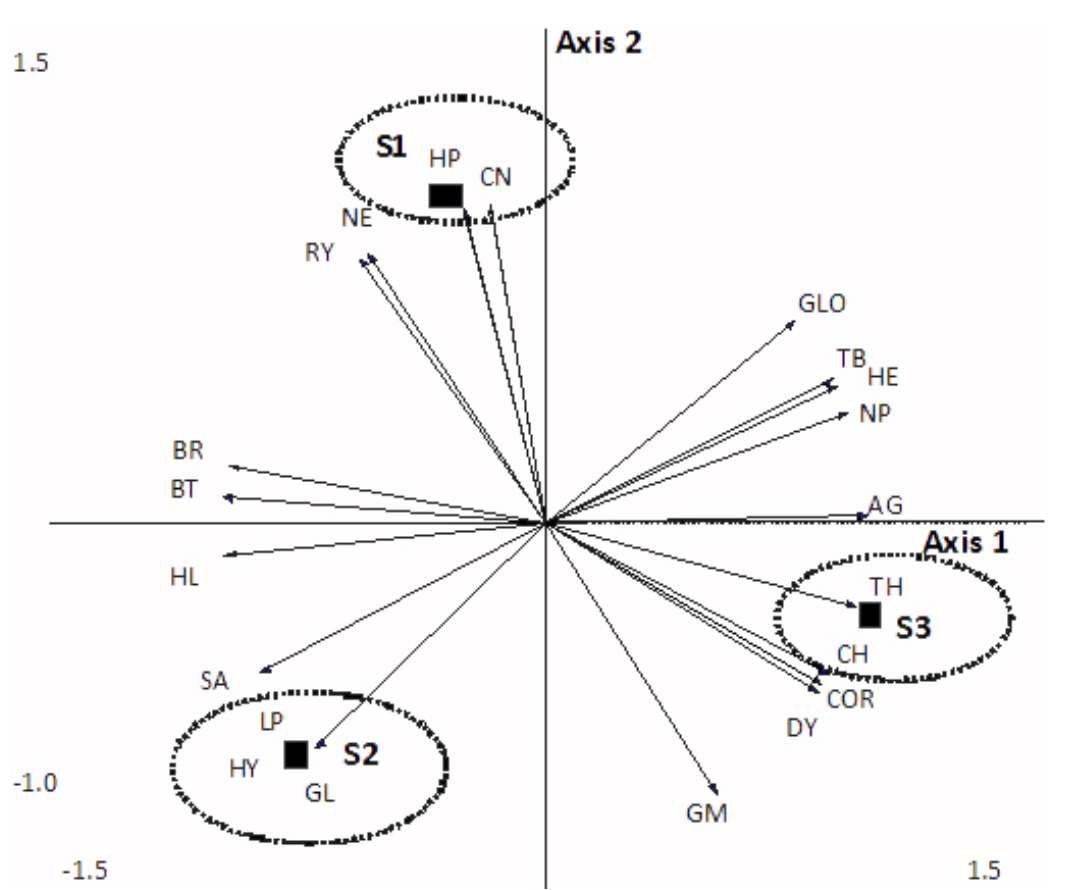
Figure 4. Principal Component Analysis (PCA): The ordination indicates the characteristic taxa through graphical presentation between the taxon (arrows) and station as well as each land use (filled square) in the river Ken. The taxa close to the station are characteristic of that station and encircled. Acronyms: AG - Agrionida; BT - Baetidae; BR - Brachycentridae; CH - Chironomidae; CN - Caenidae; COR - Corbiculidae; DY - Dytiscidae; GM - Gomphidae; GL - Glossosomatidae; GLO - Glossocolecidae; HE - Heleidae; HP - Heptageniidae; HL - Hydroptilidae; HY - Hydropsychidae; LP - Leptophlebiidae; NE - Neoephemeridae; NP- Nepthydae; PR - Perlidae; RY - Rhyacophilidae; SA - Salifidae; TB - Tabanidae; TH –